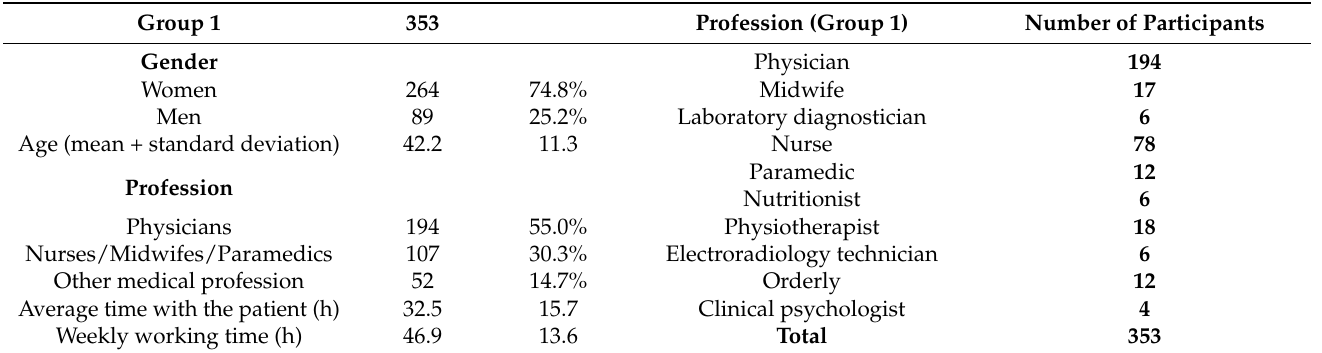
Table 4. Characteristics of group 1 with profession structure.